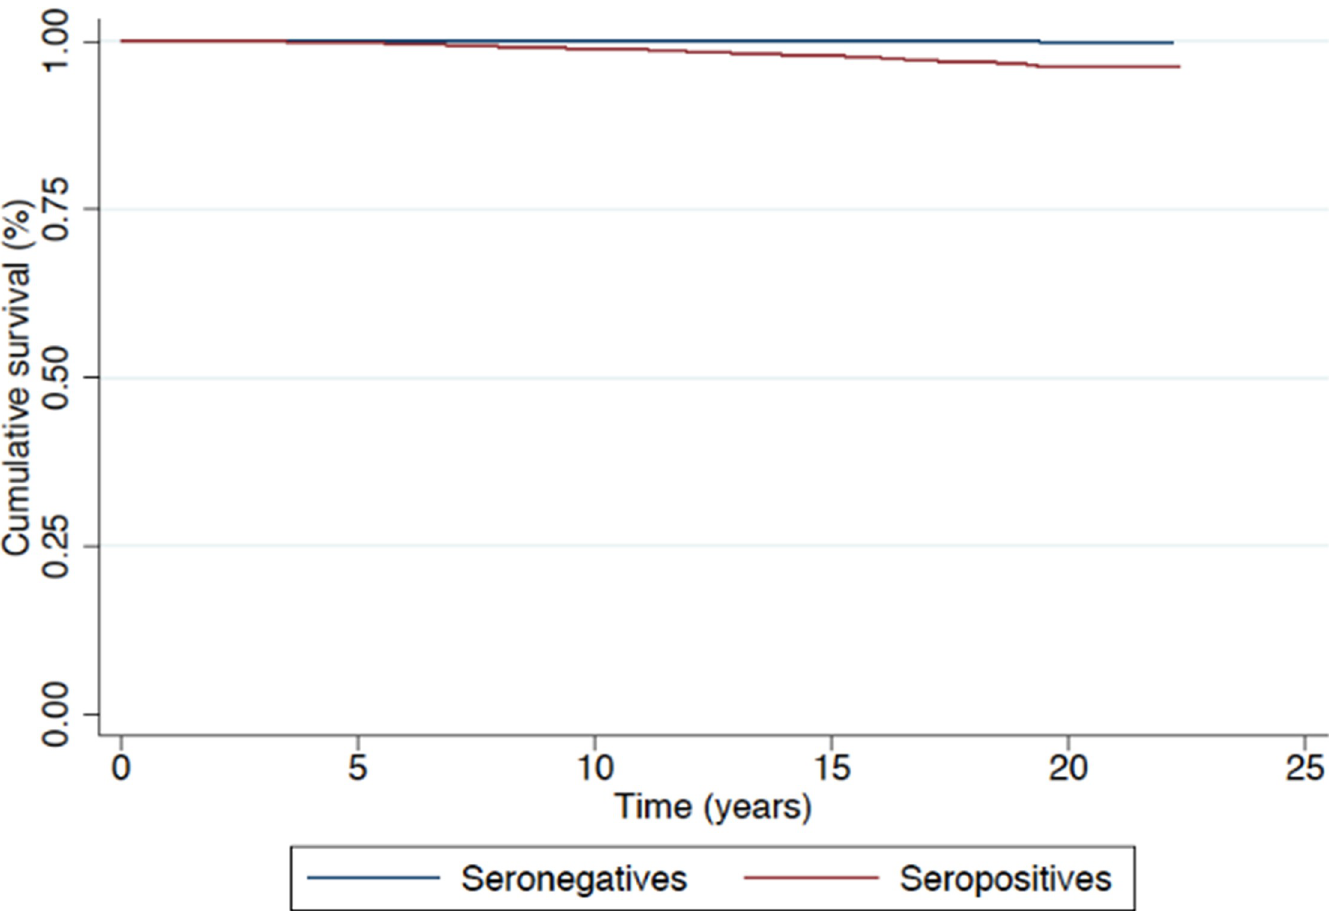
Fig 2. Survival (in years) by HCV serological status considering only causes of death related to HCV or associated with infection due to the